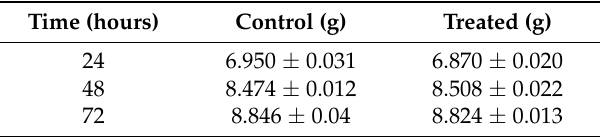
Table 4. Carbon dioxide released during fermentation (g of CO 2 per 100 g of